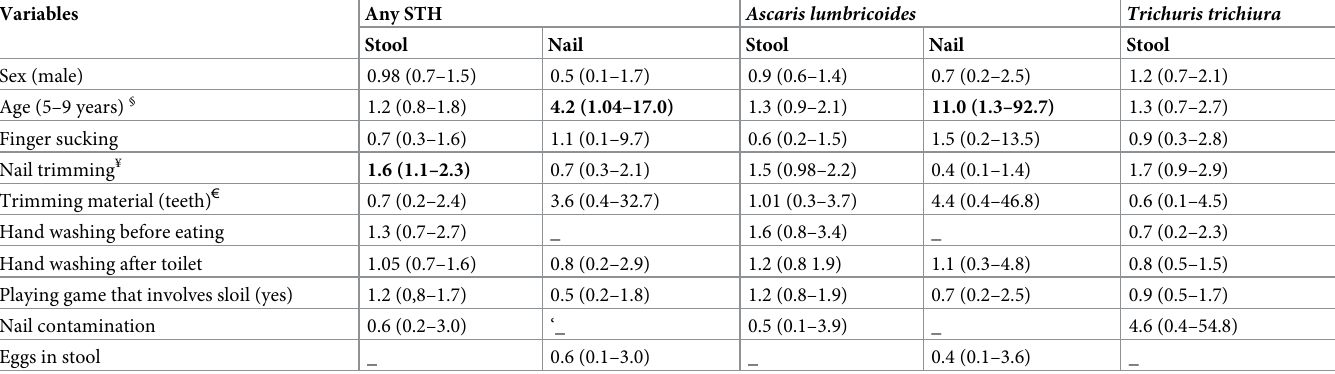
Table 1. Association between infections with soil-transmitted helminth infections, and sex, age and personal hygiene. This table reports the adjusted odds ratios (95% confidence interval) derived from the multi-variable regression models. Significant associations ( p < 0.05) are indicated in bold. § Reference: 14–18 years old; ¥ Fre- quency of trimming in decreasing ordinal order (once per week ! once per 2 to 3 weeks ! when it is long enough); € Reference: using either razor blade or nail clipper. Variables Any